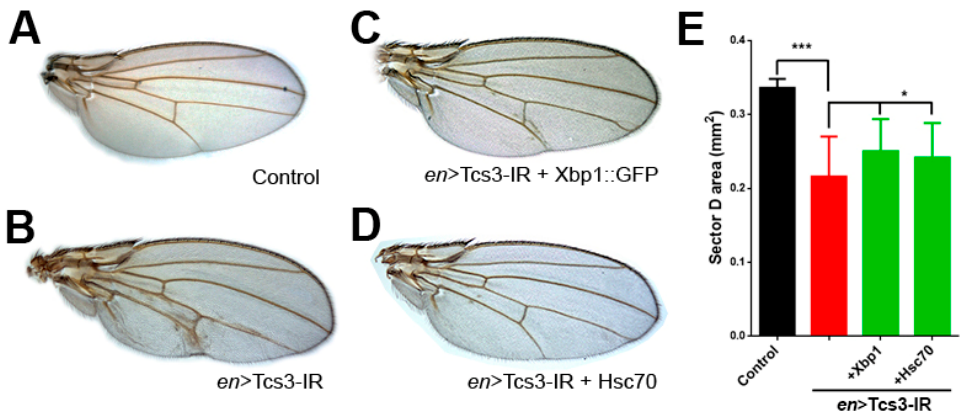
Figure 5. Enhancement of protein folding capacity of cells partially reverted wing phenotype. ( A ) Control wings ( en > Gal4/+), using the en > Gal4 driver we simultaneously knocked ‐ down tcs3 ( B ) and